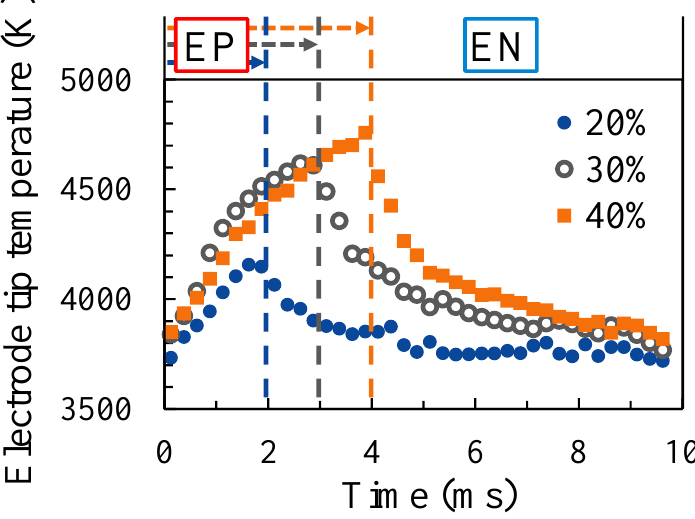
Figure 14. Temperature variation of the electrode tip for different EP ratios.